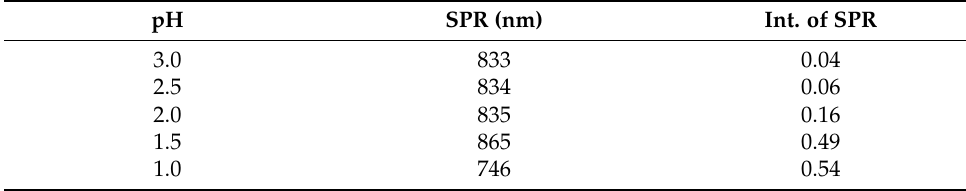
Table 3. The influence of pH to surface plasmon resonance and intensity absorbance.